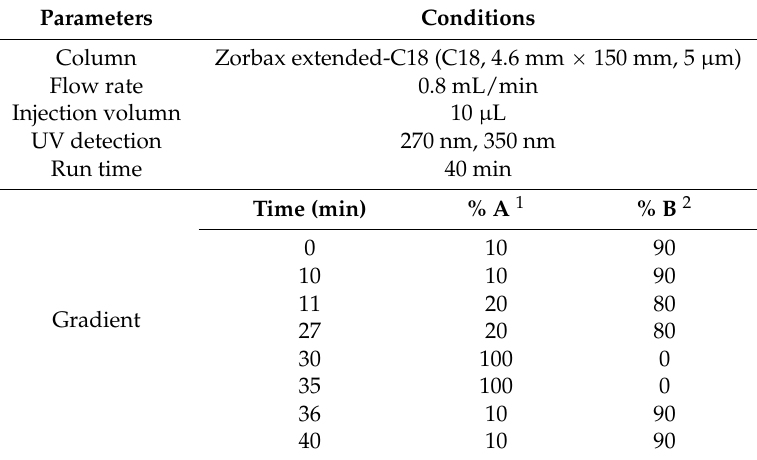
Table 7. Analytical conditions of HPLC for analysis of the four